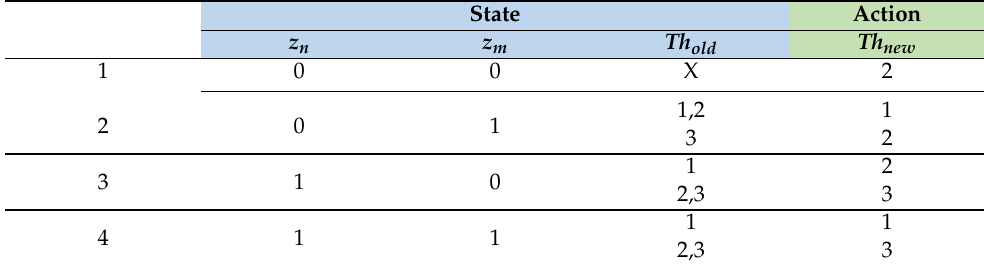
Table 2. Policy goals.